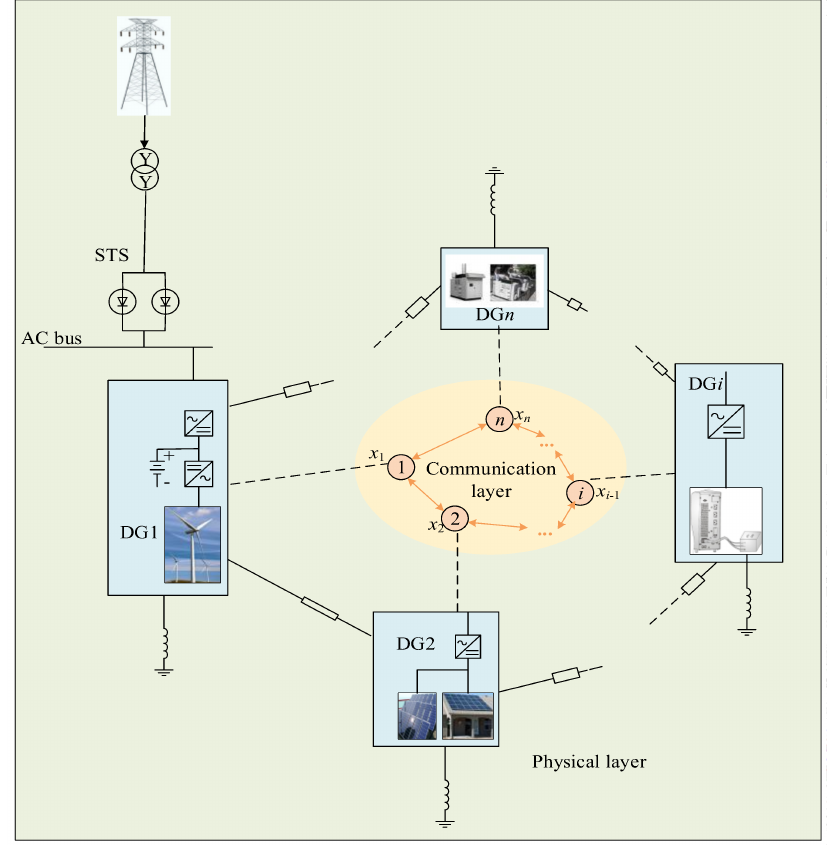
Figure 2. Two-layer structure for an alternating current (AC)